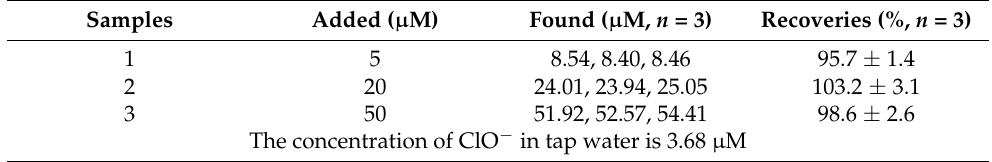
Table 2. Determination of ClO − in tap